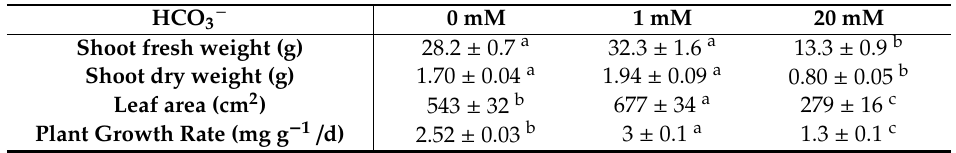
Table 3. Shoot fresh and dry weights, leaf area and growth rate of lettuce plants grown under 0, 1 and 20 mM HCO 3 − . Experiment 3. Values are means ± S.E. of 4 replicates, with di ff erent letters within a row denoting significant di ff erences between means (post-hoc LSD p <